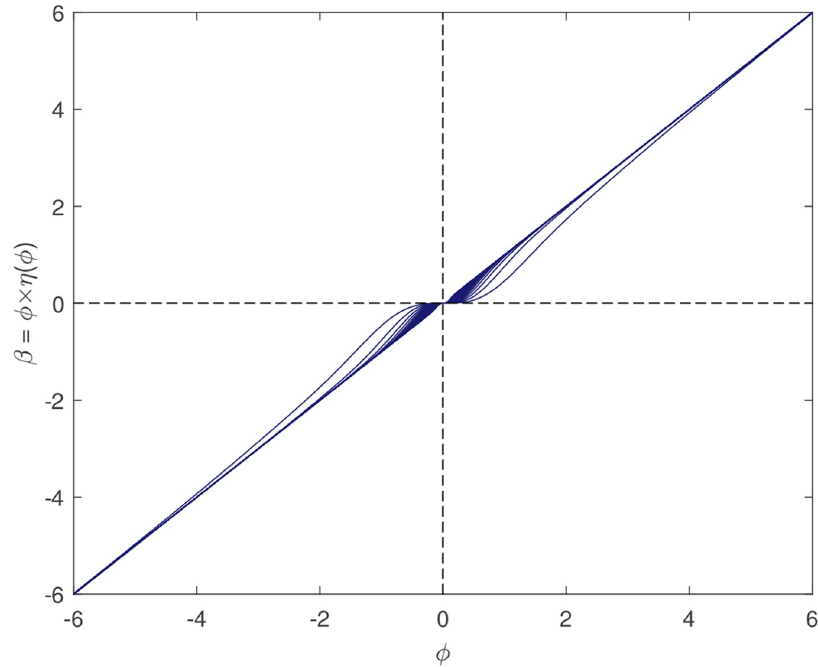
Fig 2. Plot of β i and ϕ i . This plot shows desired mutually one-to-one mapping, which is strong evidence supporting reparameterizations. With γ varying from 1 to 100, the function becomes closer to f ( ϕ ) = ϕ .